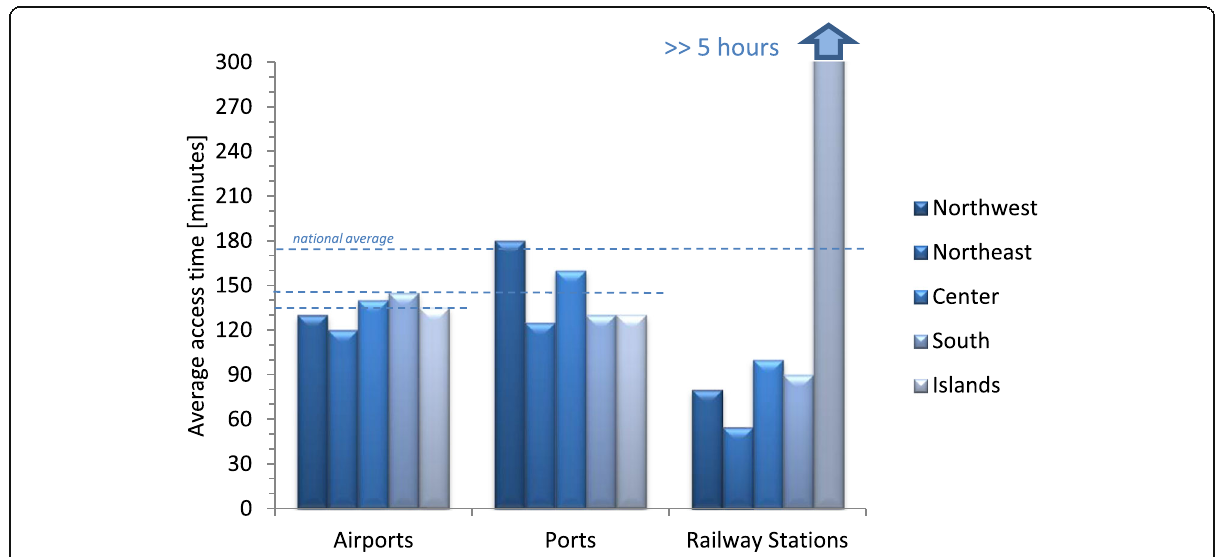
Fig. 8 average access travel costs (expressed in minutes) using public